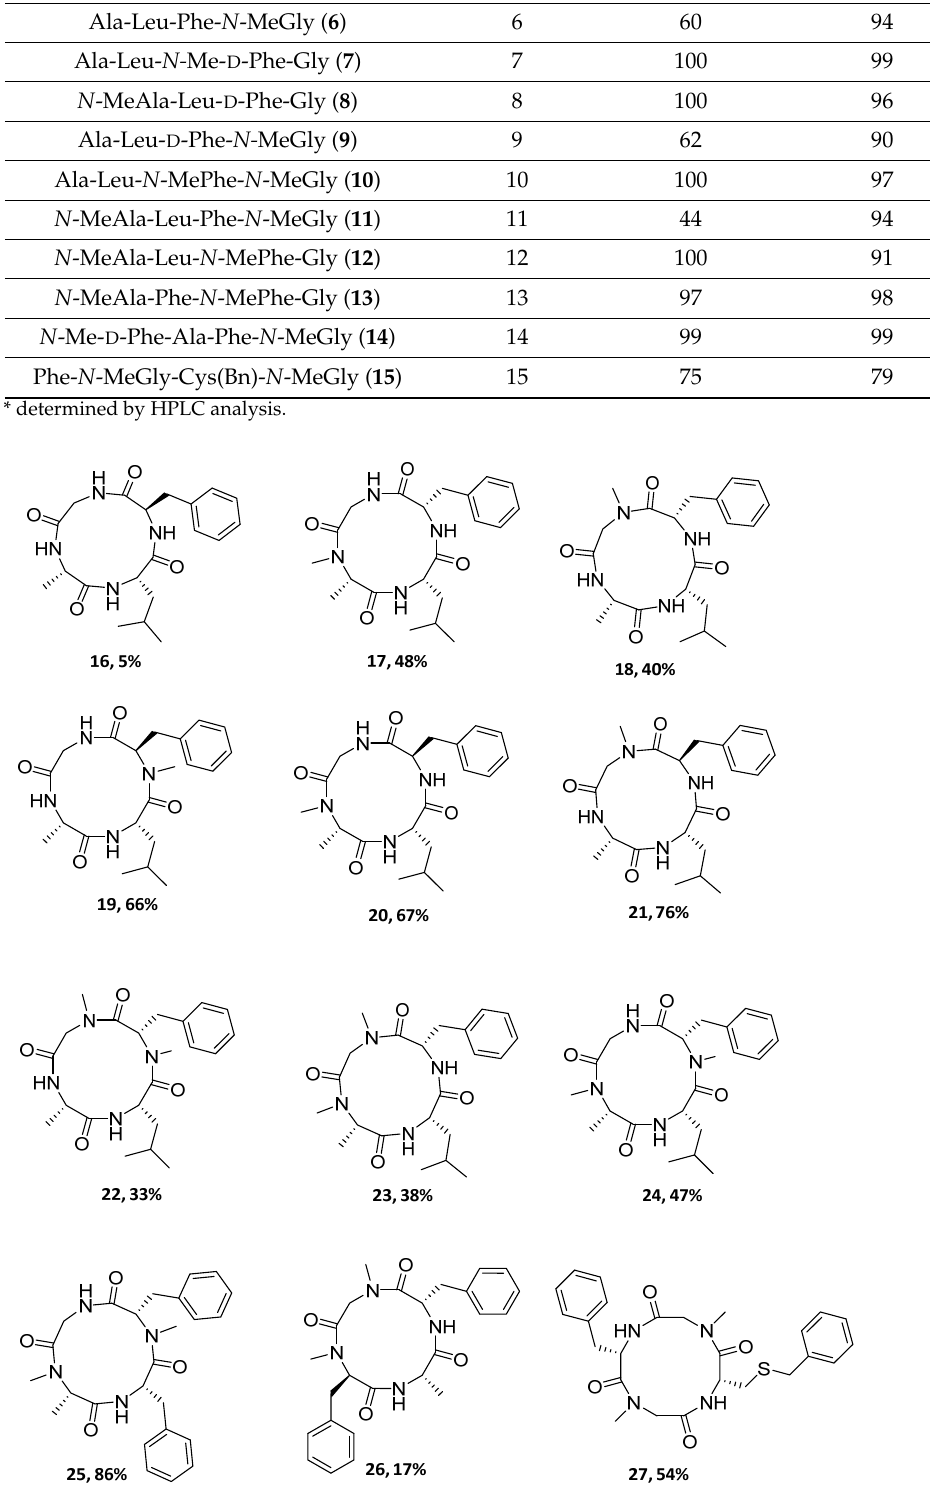
Table 2. Peptide precursors, cyclotetrapeptides and macrocyclization yield.